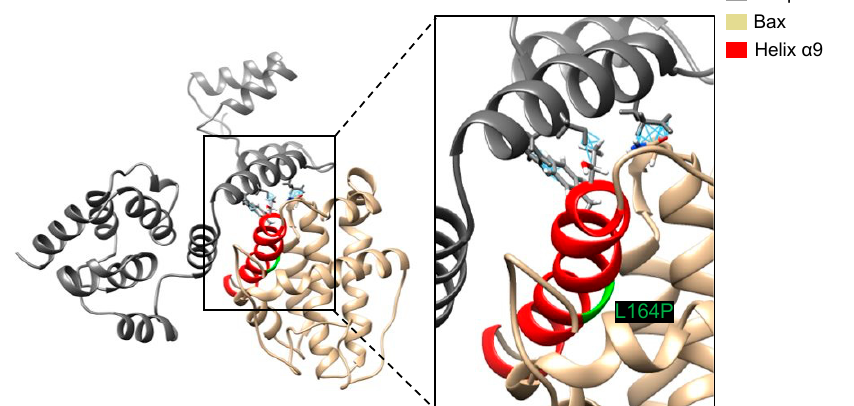
Figure 8. The interaction between Bax ∆ 2 [L164P] and caspase 8 DED after superposing Bax ∆ 2[L164P] to the lowest docking pose of Bax ∆ 2. A closeup view of the binding site is shown on the right. The location of P164 is marked green and close contacts are shown with blue lines.